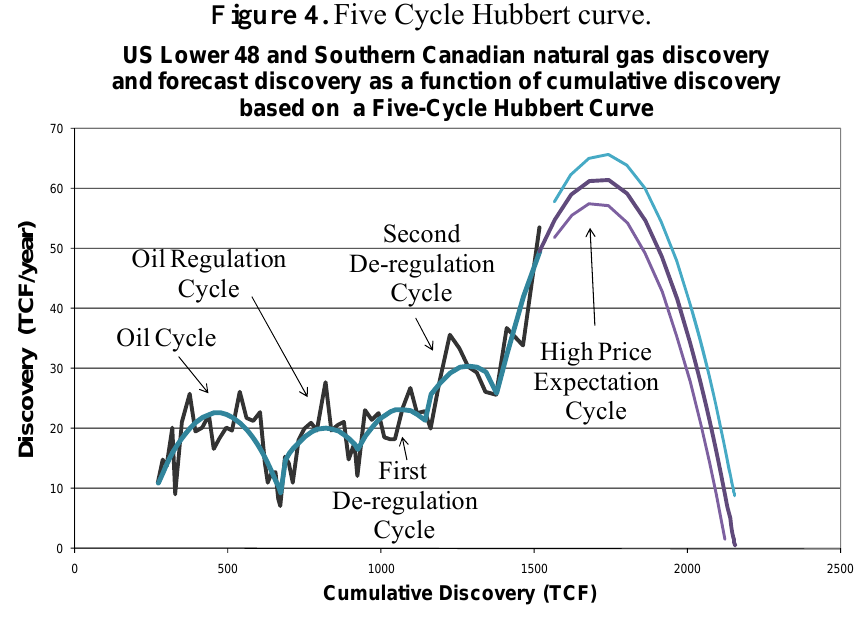
Figure 4. Five Cycle Hubbert